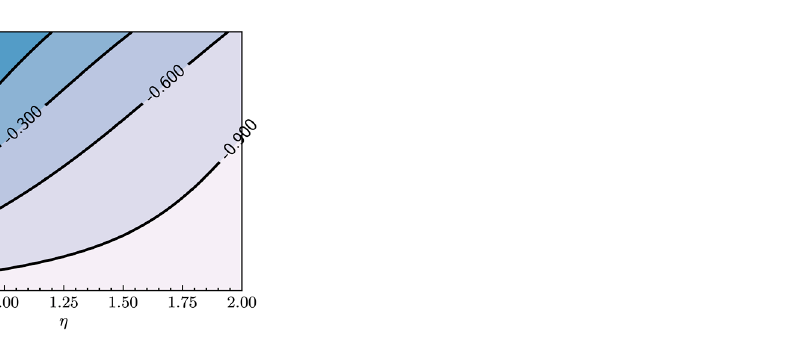
Figure 4. Evolution of the dilatancy ratio d with respect to the fractional − order α and the stress ratio η .